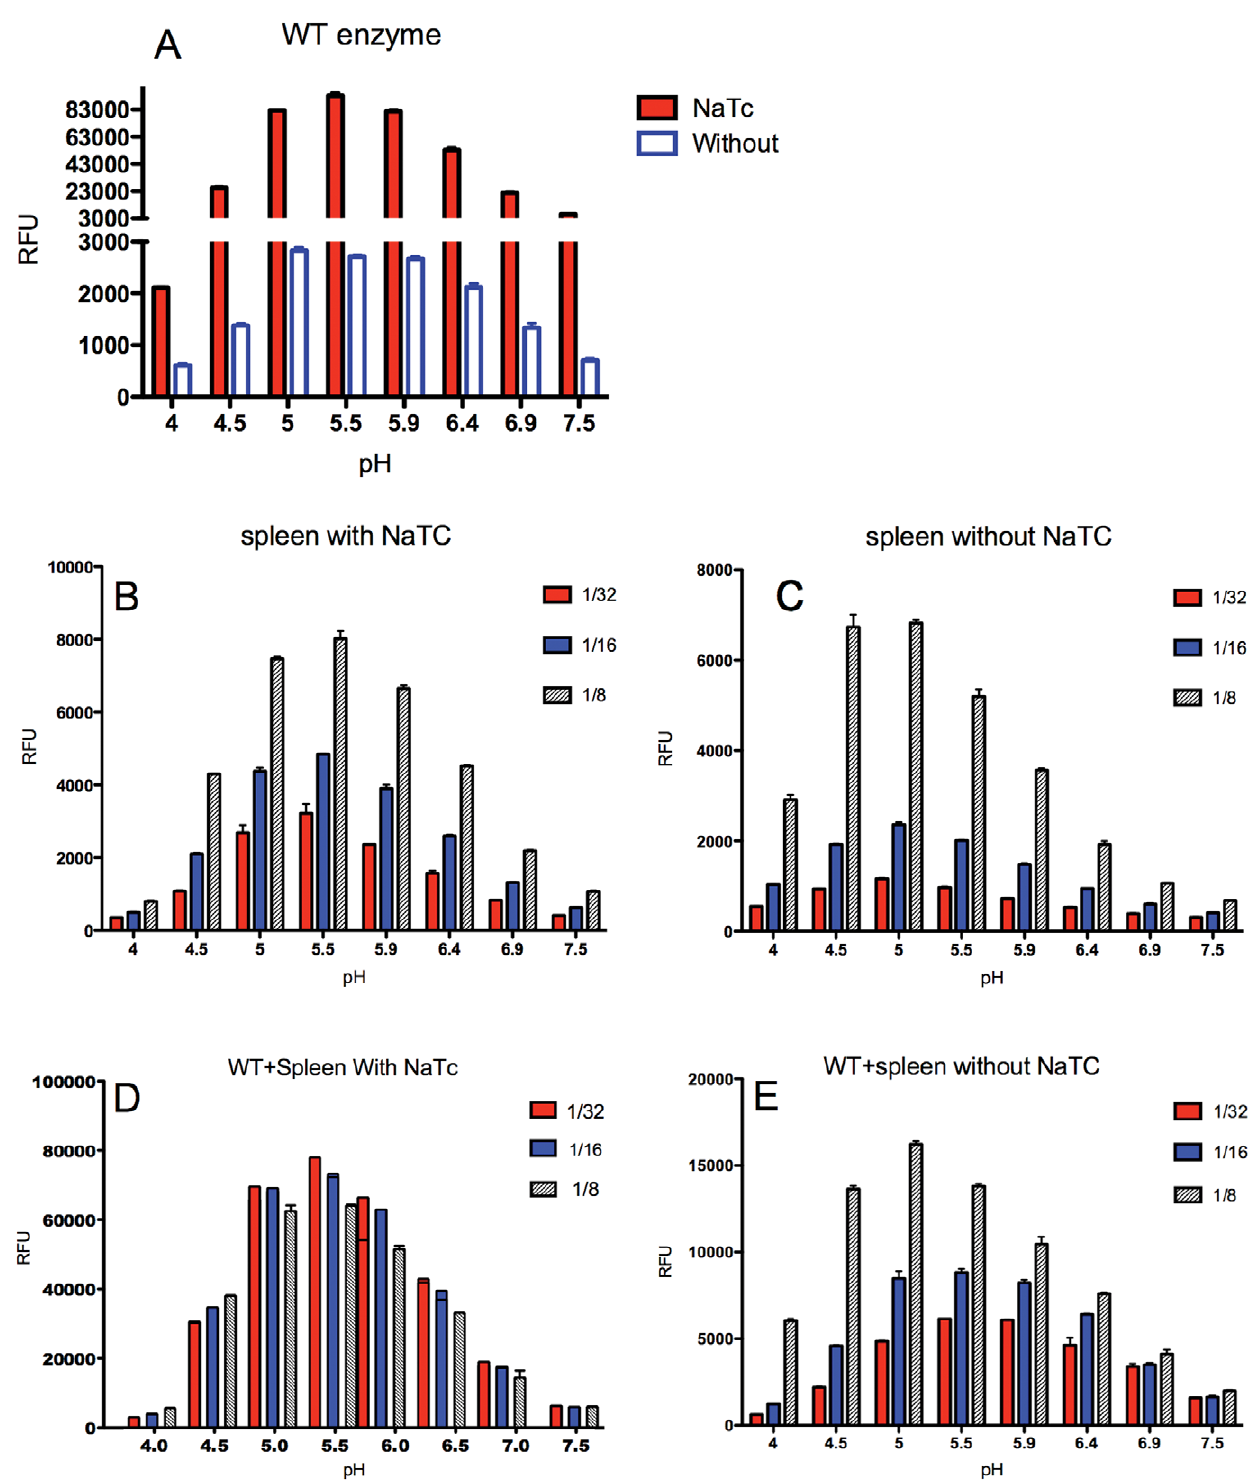
Figure 4. Effect of adding the spleen preparation on the activity of WT recombinant GCase. pH dependency and effect of sodium NaTC on the recombinant enzyme activity were assayed. A. activity of WT recombinant enzyme with and without NaTC. B and C. Different dilutions of N370S spleen in the presence (B) or absence (C) of NaTC. D. and E. WT recombinant enzyme mixed with increasing concentrations of spleen extract with (D) and without (E) NaTC.